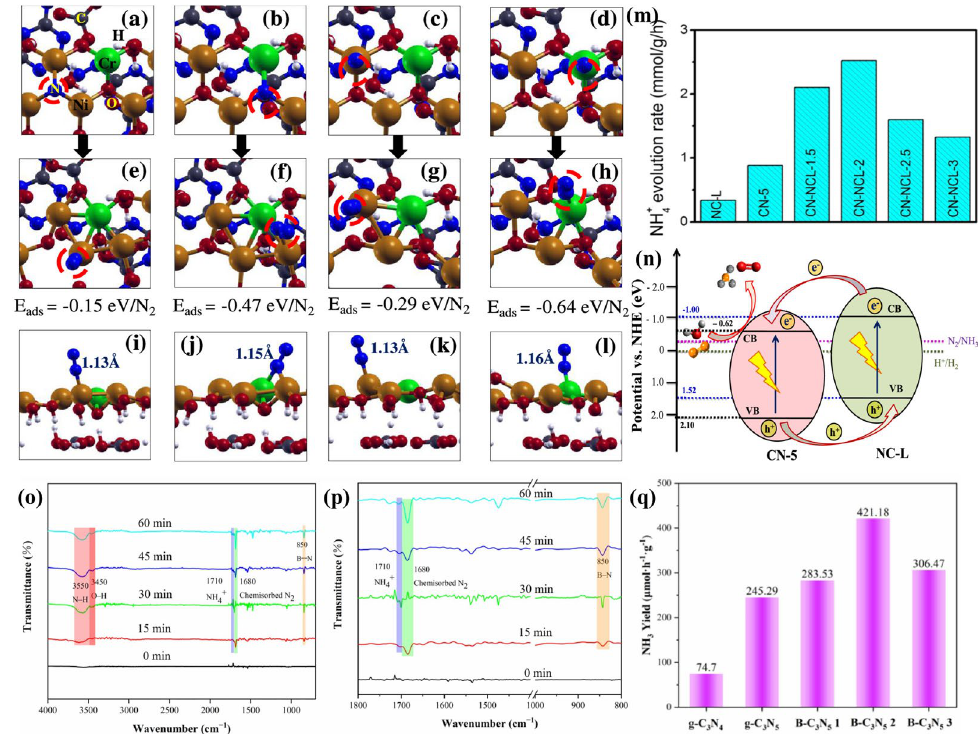
Figure 17. (a − d ) Initial structure (red circles: the binding position); ( e − h ) corresponding optimized structures; ( i – l ) corresponding N − N bond distances; ( m ) Photocatalytic ammonia production rates of g-C 3 N 5 /NiCr-LDH; ( n ) Schematic illustration of a mechanism for NH 3 production using g- C 3 N 5 /NiCr-LDH; ( o − p ) In-situ DRIFTS spectra of B-C 3 N 5 ; ( q ) NH 3 yields for g-C 3 N 5 and B-C 3 N 5 x (x = 1, 2, 3). ( a − n ) Adapted with permission from [70]. Copyright Elsevier B.V., 2022. ( o − q ) Adapted with permission from [37]. Copyright American Chemical, 2020.